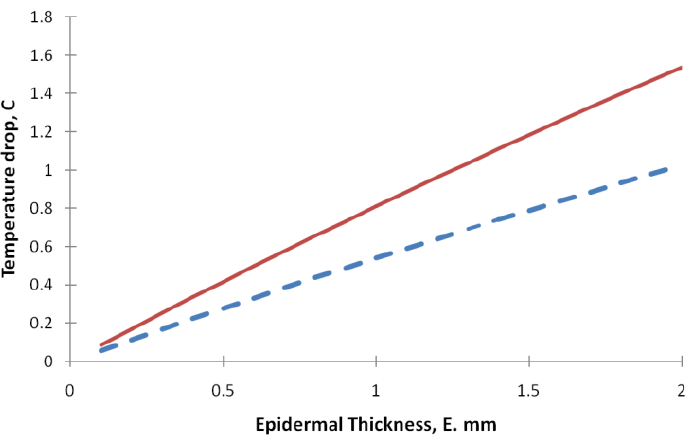
Figure 3. The dependence of the epidermal temperature drop Δ T e as a function of the passive layer thickness E for two dermal temperatures/ambient temperature gradients: ( T d − T ∞ ) 15 °C (solid red) and 10 °C (dashed blue).